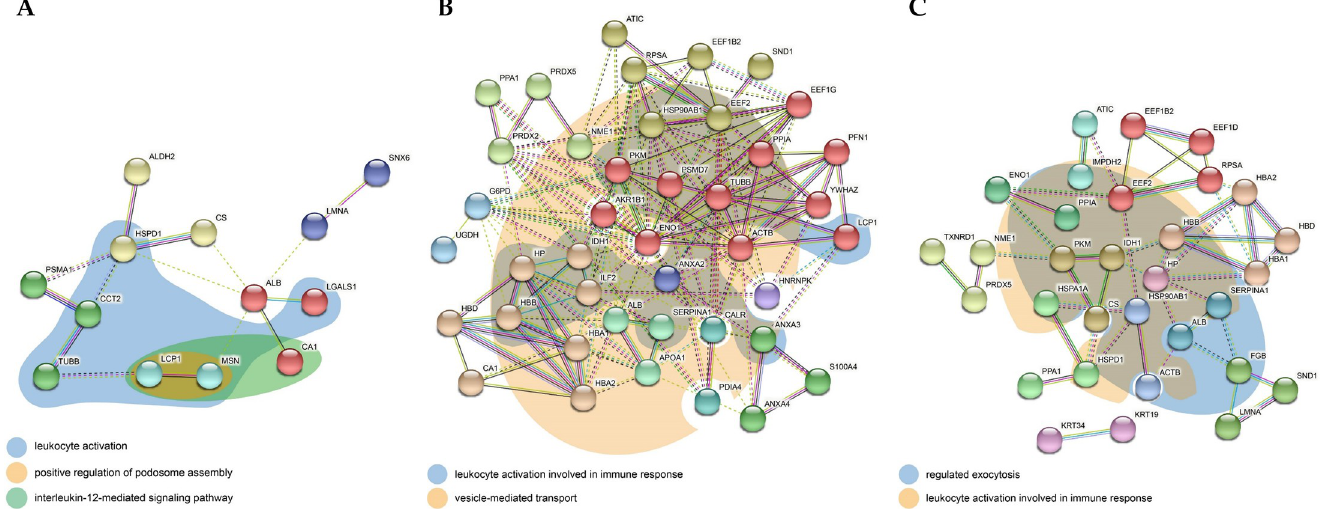
Fig 4. Protein-protein interaction network of differentially expressed proteins in (A) margin vs. center, (B) center vs. control, (C) margin vs. control comparison for ADC. The network nodes represent proteins while the edges represent predicted functional associations. There are 5 types of associations presented: neighborhood (green), experimental (purple), text mining (yellow), database (light blue), coexpression (black) evidence. The color of the nodes represents cluster membership. Inter- cluster edges are depicted by dashed lines. The colored areas represent functional